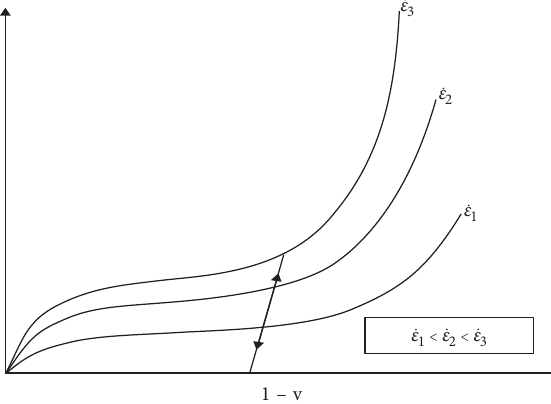
Figure 23: Constitutive principle of MAT_MODIFIED_CRUSH